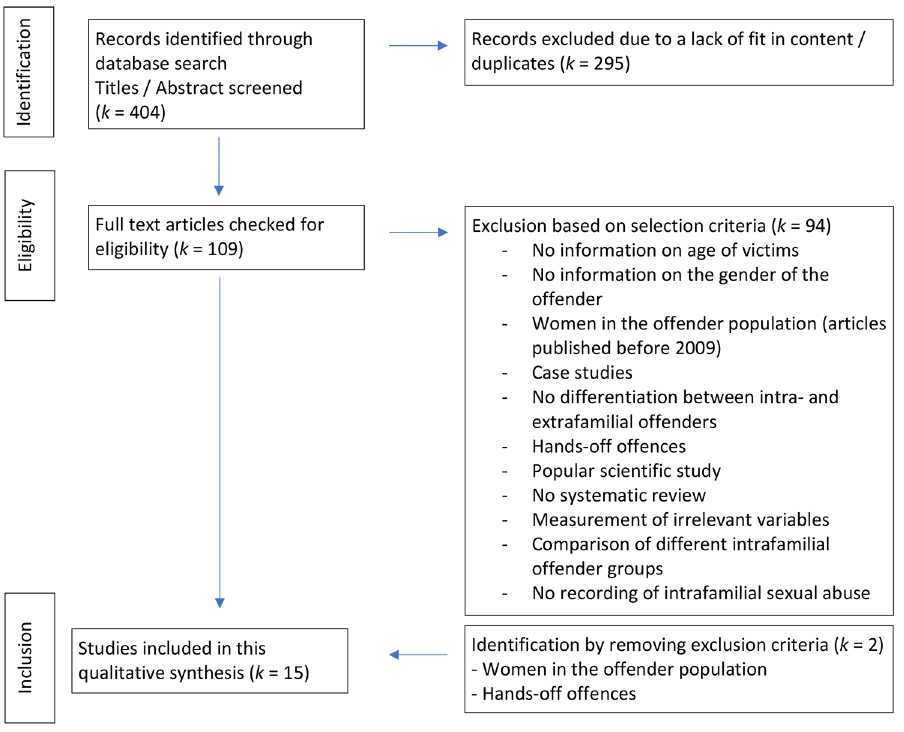
Study Selection Based on the PRISMA